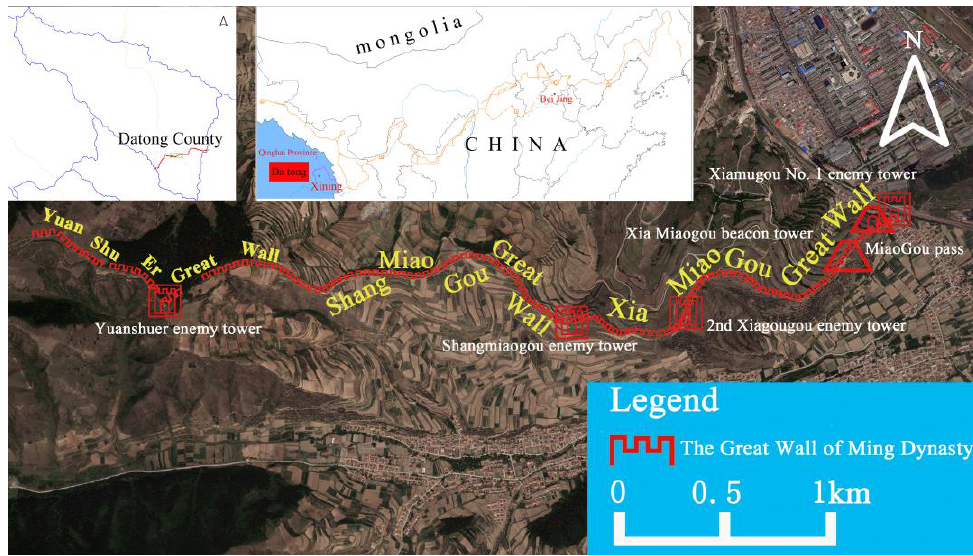
Figure 1. Location of the Great Wall of the Ming Dynasty in Datong County of Qinghai Province, China.